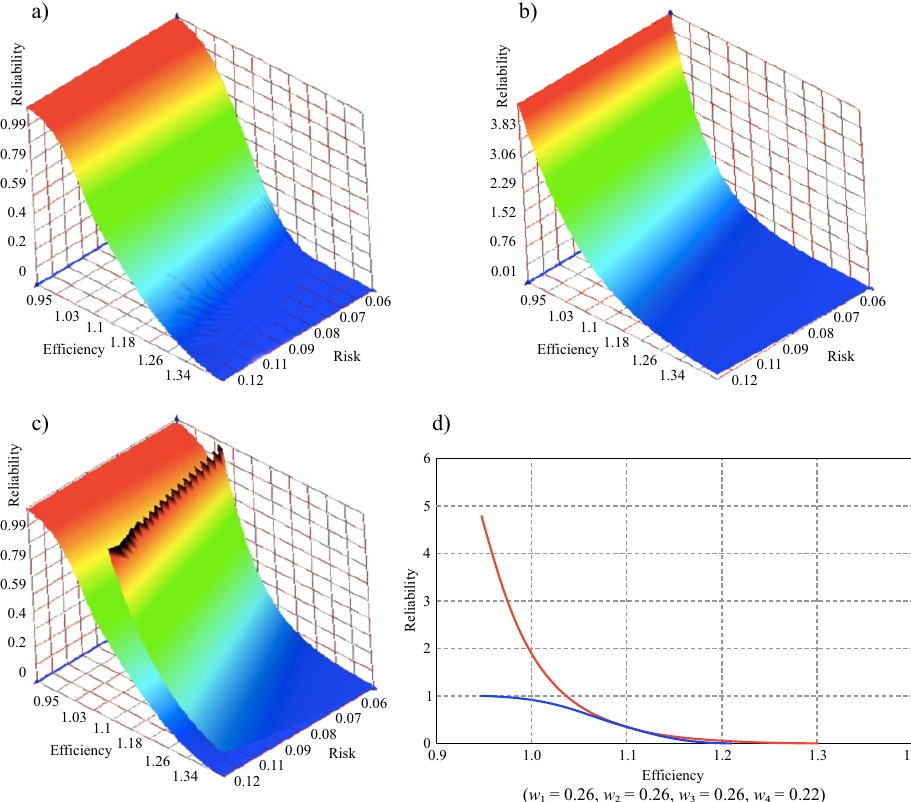
Fig. 4. Scheme of the optimal investment resource allocation, where the highest values of possibilities of probabilities coincide with the interval average: efficiency possibilities (a), utility function (b), surface contact point (c), optimal solution